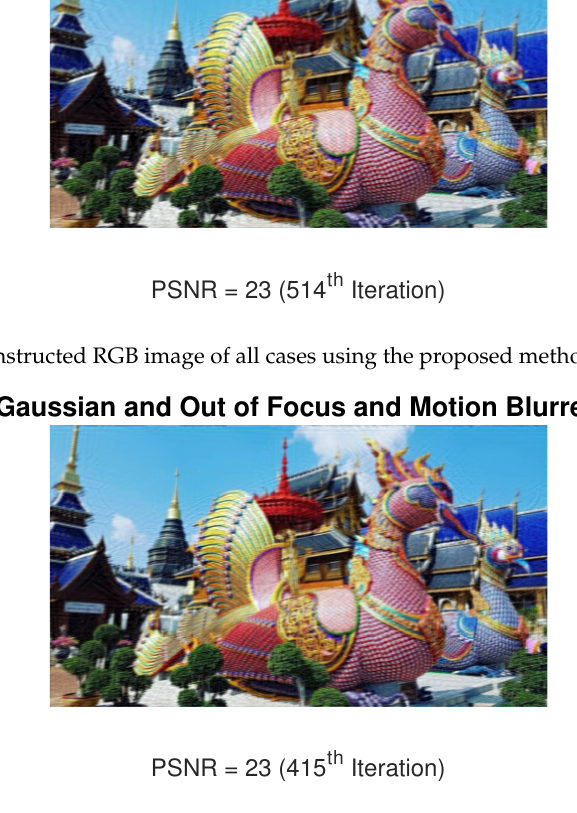
Figure 49. The reconstructed RGB image of all cases using the proposed method (2) with PSNR =